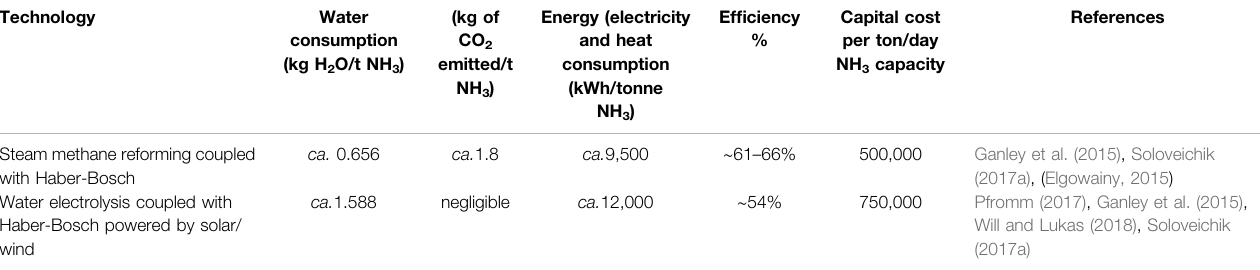
TABLE 5 | Key consumption and GHG emissions for renewable and conventional ammonia production technologies to produce 1 tonne of ammonia.